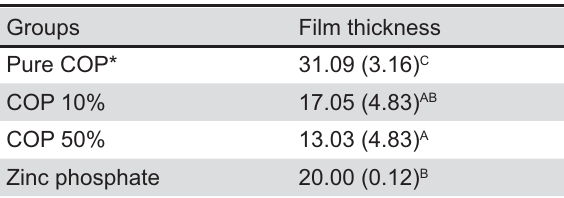
Table 2- Film thicknesses (μm) of dental luting agents and standard deviations